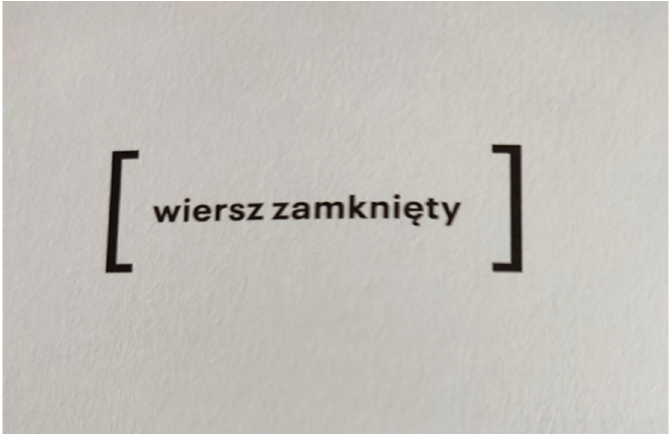
Figure 9. Krystyna Mi ł ob ę dzka.2020. wiersz zamkni ę ty (closed poem) jest/jestem (is/I am), Lusowo: Wolno, p. 258. (Mi ł ob ę dzka [2000] 2020r, p. 258).